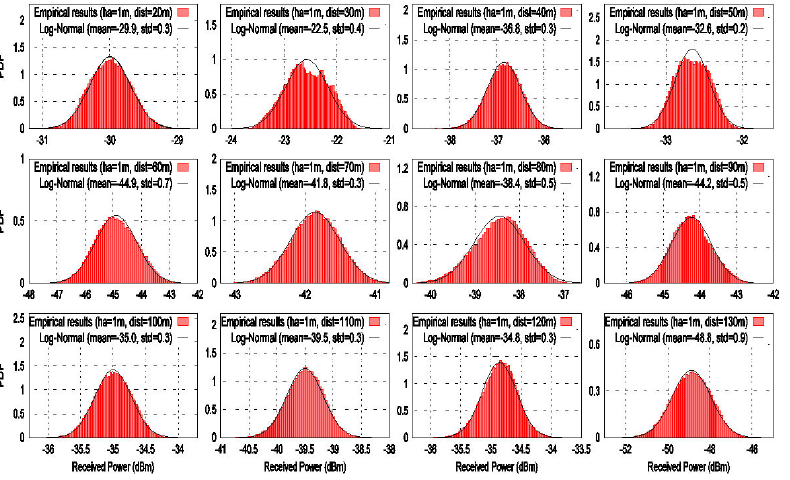
Figure 10. Histograms at each distance from 20 m to 130 m for a height of 1 m over the river within vegetation.